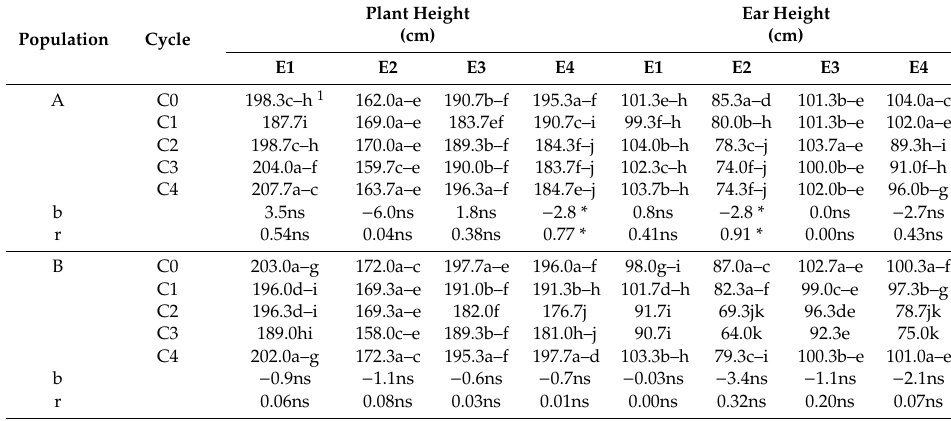
Table A3. Means for plant height and ear height of (A–E) five populations and (C0–C4) five cycles evaluated in four